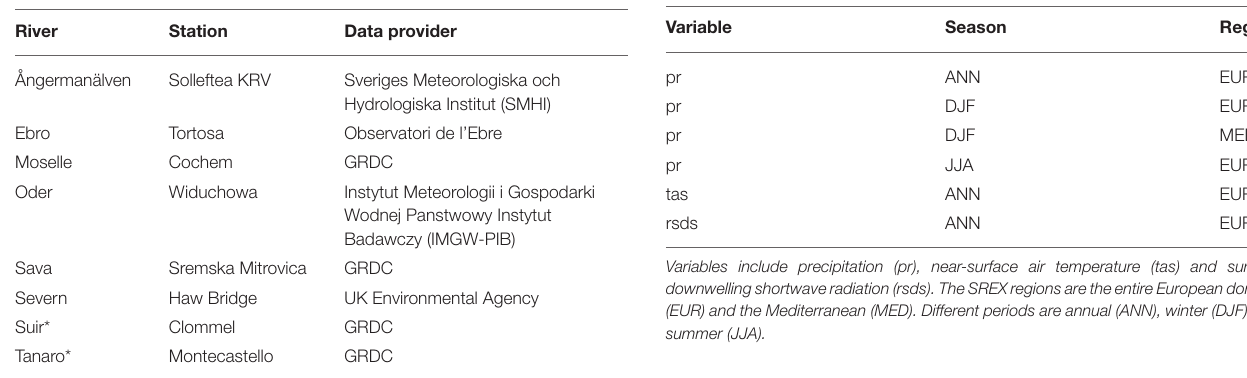
TABLE 4 | Information on which the diagnostics used to calculate D i and S ij is